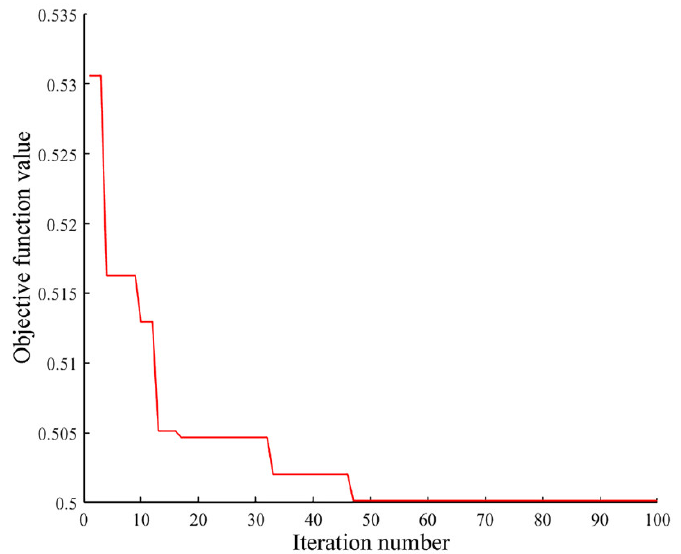
Figure 10. Convergence curve.